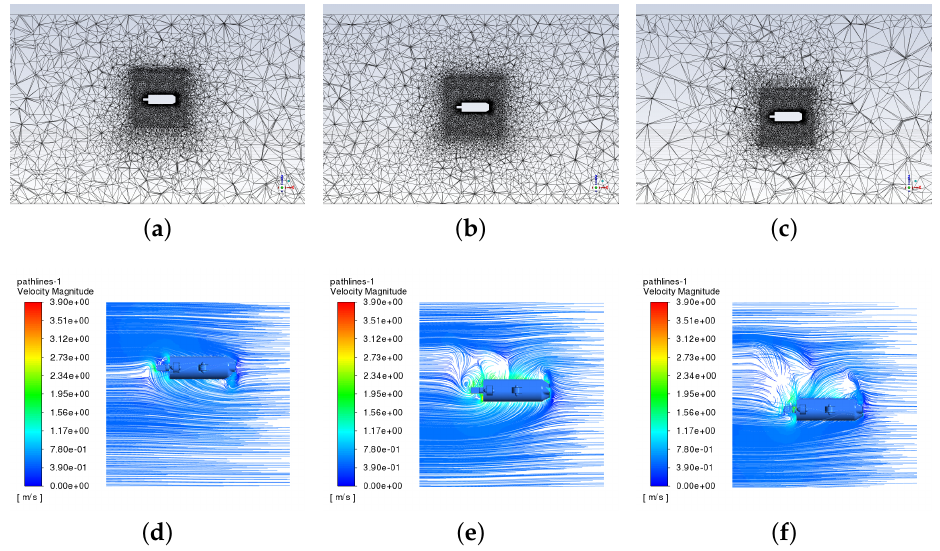
Figure 13. Mesh deformation and movement for pure heave motion of the underwater vehicle at ( a ) t / T 0 = 0.25; ( b ) t / T 0 = 0.50; and ( c ) t / T 0 = 0.75. Flow field streamlines around the underwater vehicle for pure heave motion at ( d ) t / T 0 = 0.25; ( e ) t / T 0 = 0.50; and ( f ) t / T 0 = 0.75.